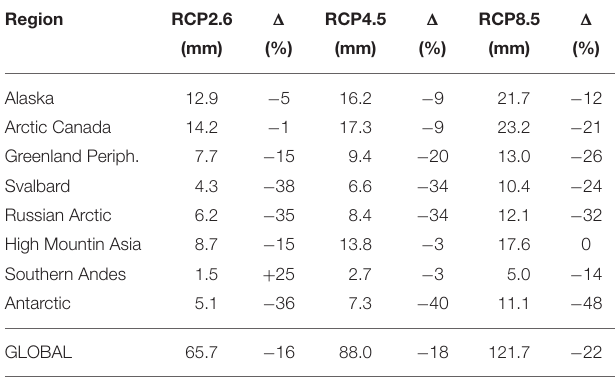
TABLE 3 | Regional estimates of SLE eff by 2100 for selected regions calculated with the energy balance model. Region